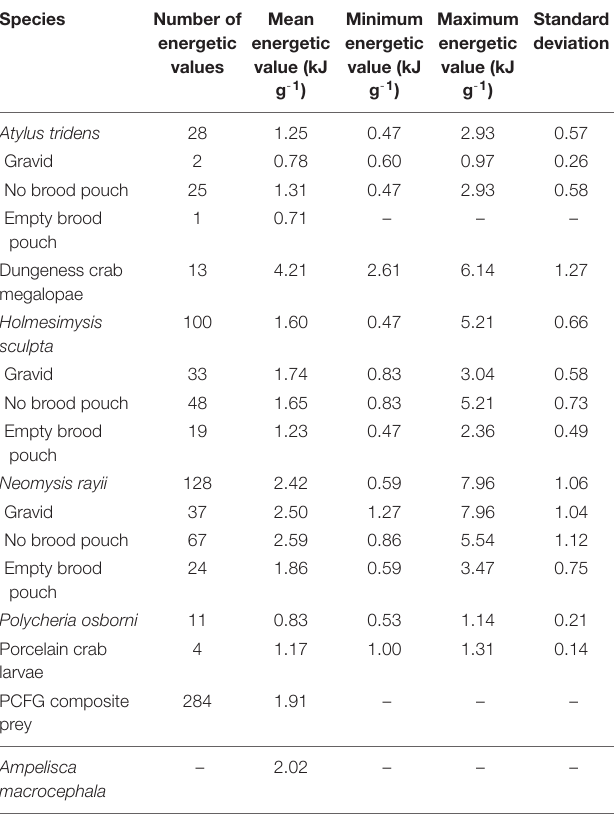
TABLE 1 | Energetic values (wet weight) and sample sizes by zooplankton species and reproductive group collected from June to October in 2017 to 2019 in central